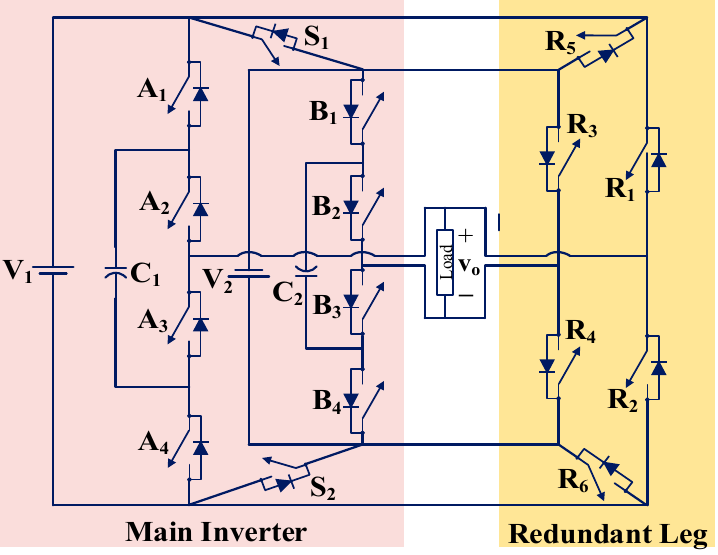
Figure 8. Single-phase nine-level FT MLI (TP7) [35]. The phase-disposition SPWM (PD-SPWM) scheme is employed for generating switch- ing pulses in the topology. The topology uses the LA FT solution for fault tolerance. The topology does not include any bidirectional switches. The topology can generate voltage levels under single and multiple OC faults while preserving output power both in healthy and post-fault operations. The merits of this topology include the efficiency achieved in post-fault conditions being higher as compared with the healthy operation, the ability to tolerate single- and multiple-switch OC and SC faults, and the self-balancing of the flying capacitor voltage both in healthy and post-fault operation. No utilization of redundant legs’ switches under healthy conditions is the limitation of the